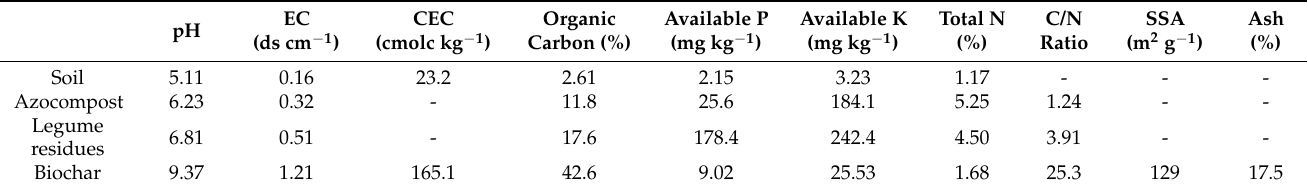
Table 1. Chemical characteristics of soil and applied materials.